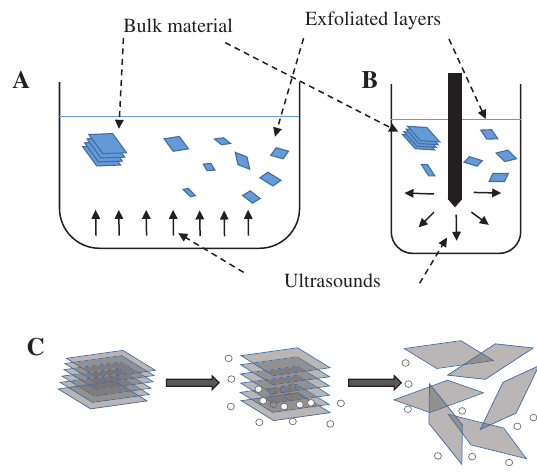
Figure 1: Schematics of the main exfoliation